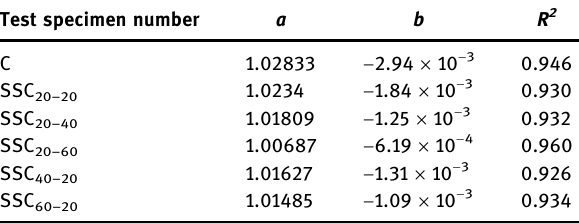
Table 8: Results of fi tting parameters of exponential function Test specimen number